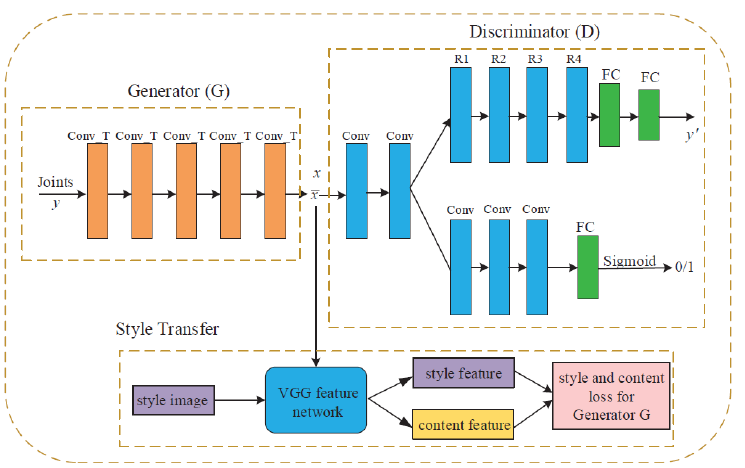
Figure 2. Flowchart of the proposed method in [30], covering the generator, the discriminator, and style-transfer networks in detail. Originally used in